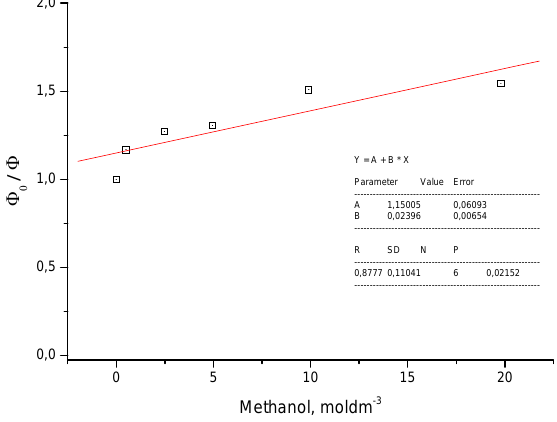
Figure 15. Quenching of fluorescence of 8 in chloroform by polar methanol (Stern- Volmer-like plot K = 0.024 mol − 1 dm 3 SV